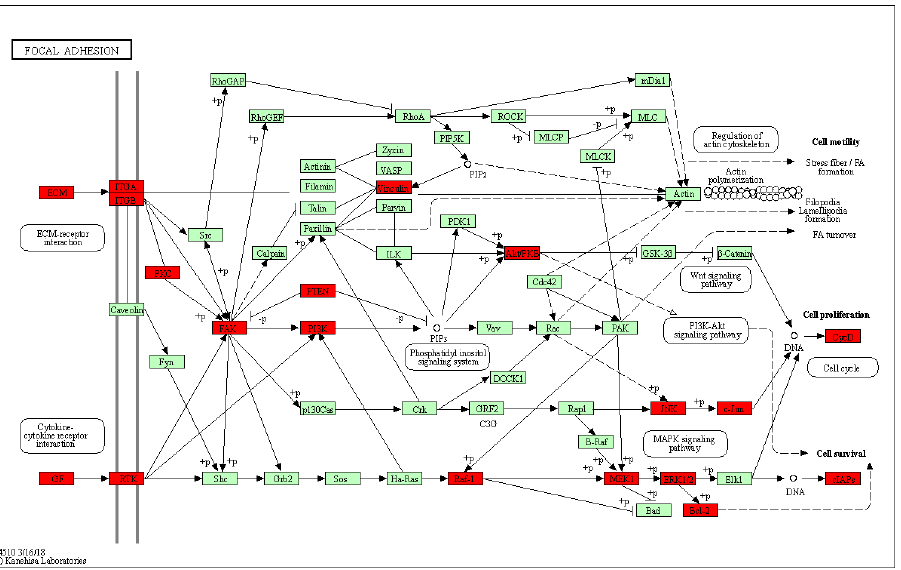
Figure 5. Predicted targets of genistein’s action in the focal adhesion pathway. Proteins highlighted in red indicate potential targets of genistein’s action against human cervical cancer.